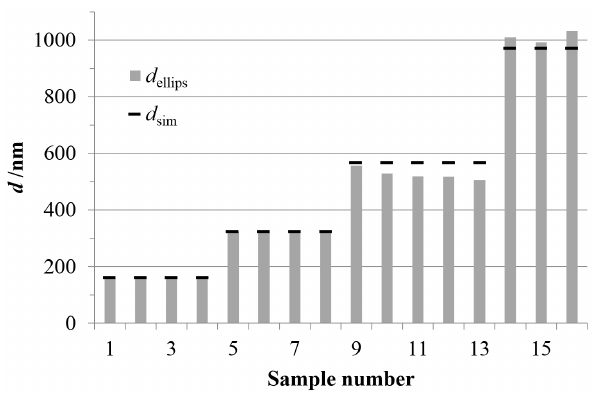
Figure 5. Measured and calculated film